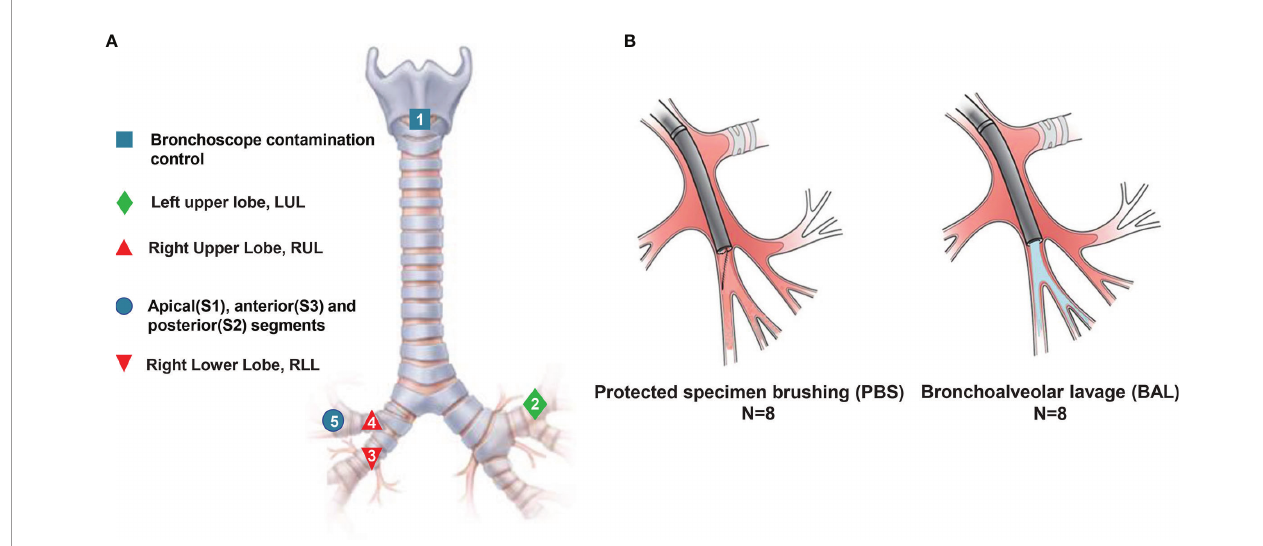
FIGURE 1 | Experimental design model. Eight patients with no infectious respiratory diseases underwent serial sampling by ENB, and a series of approaches such as spatiotemporal interleaving was used to prevent cross-contamination. (A) Sampling methods and locations. Numbers refer to the sampling order. (B) Schematic diagram of methods: avoiding contact with airway mucosa when brushing a discrete area of the airway mucosa in PSB (left), and sampling airways distal to the wedged bronchoscope in BAL